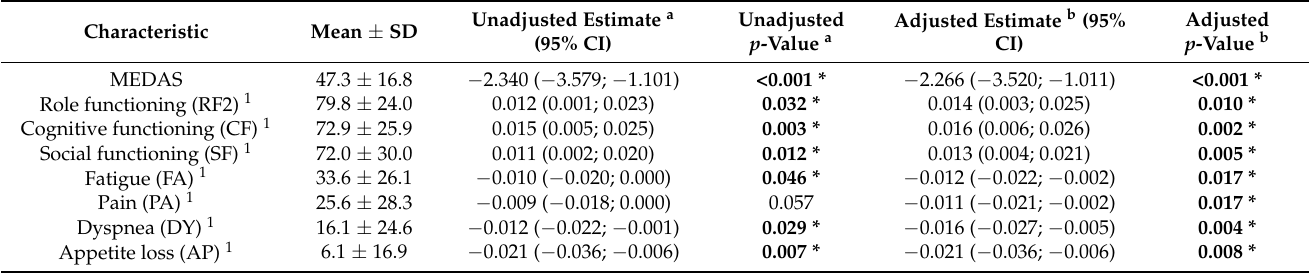
Table 2. Associations between DII and metabolic, lifestyle and HRQoL factors using linear regres- sion